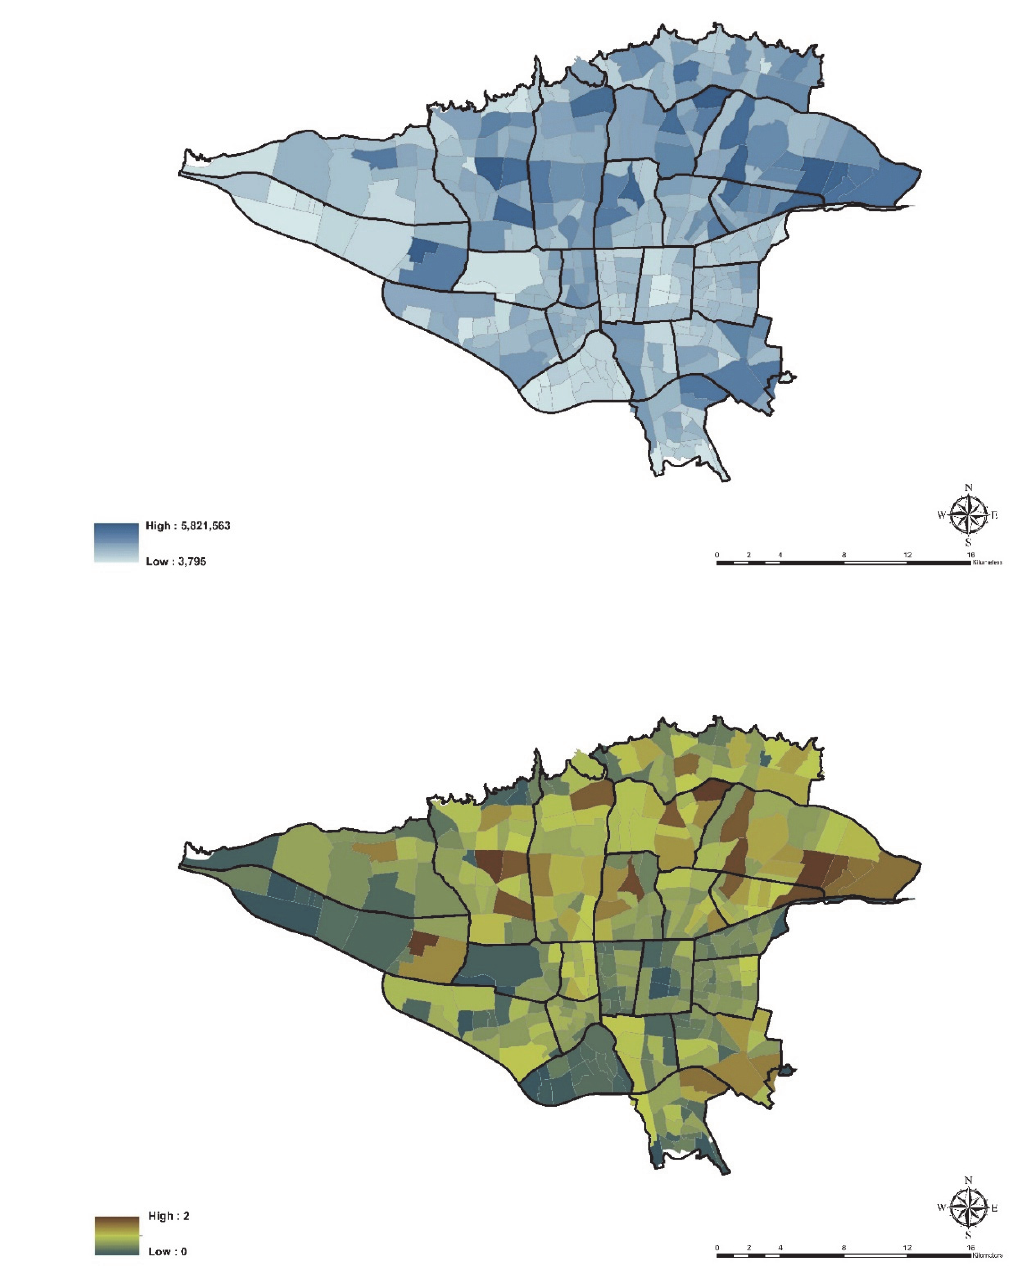
Figure 9. ( a ) Water consumption of city neighborhoods in the warm season; ( b ) neighborhoods water consumption from the total consumption(percentage) in the warm season; ( c ) water consumption of city neighborhoods in the cold season of the year; ( d ) neighborhoods water consumption from the total consumption (percentage) in the cold season.